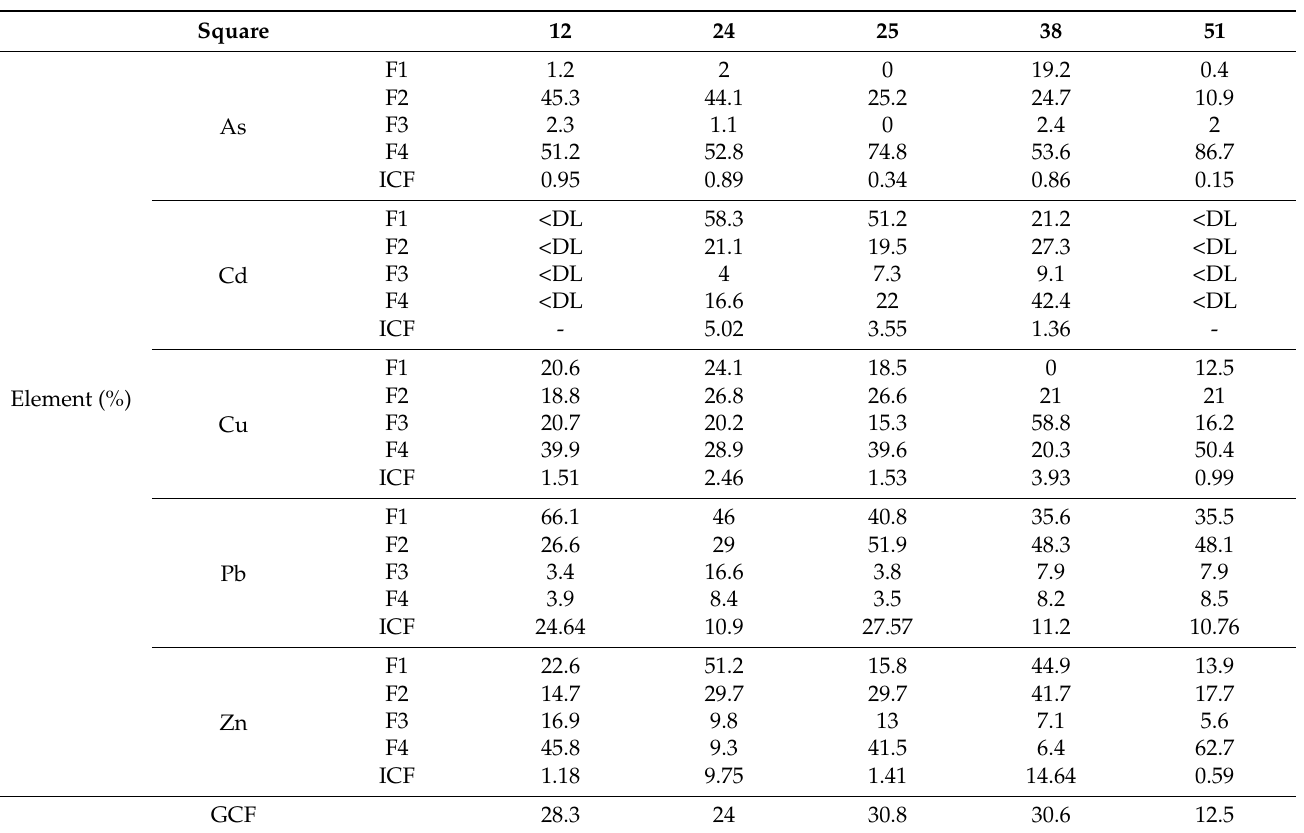
Table 4. Percentages of the four main fractions: bioavailable (F1), labile (F2), immobile (F3), and refractory (F4) and individual contamination factors (ICF). Note that Cd results for squares 12 and 51 were not significant as the low initial concentration of this metal is closed to detection limits